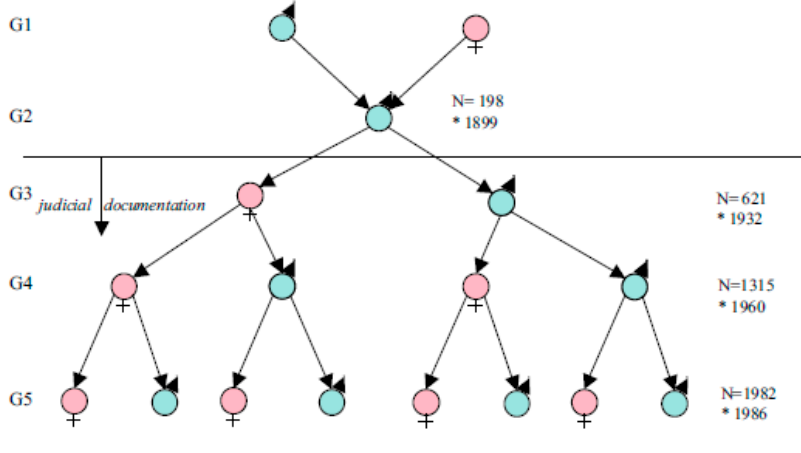
Figure 1. Study design of the Transfive study.